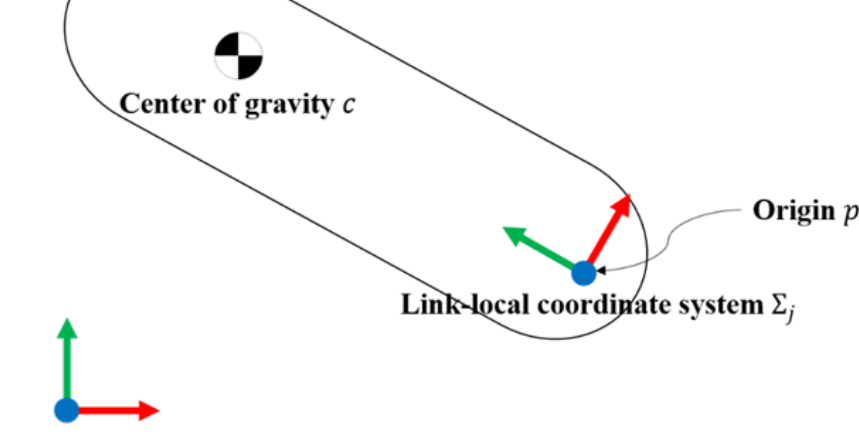
Figure 13. Schematic of a rigid link.